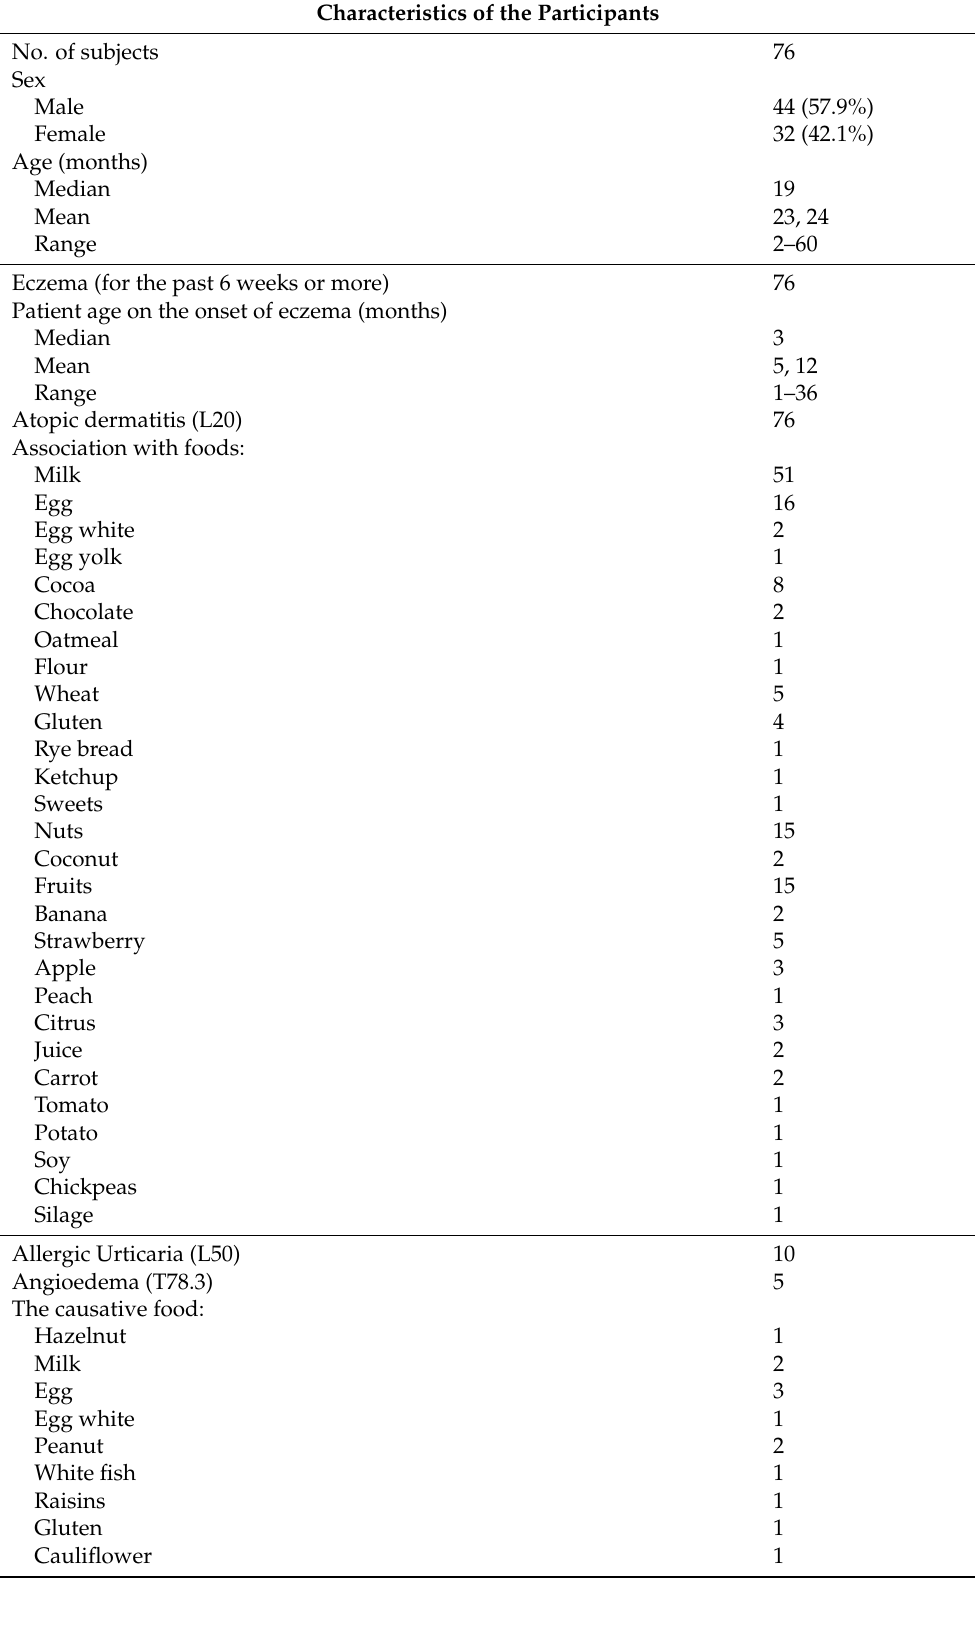
Table 6. Characteristics of the